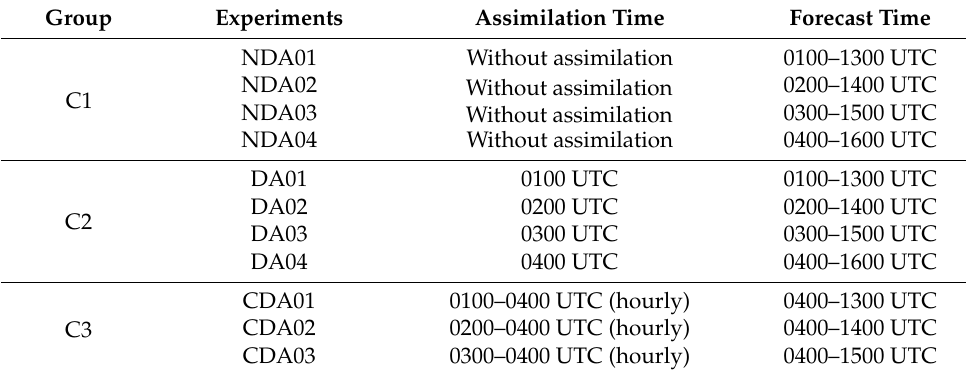
Table 1. Design of